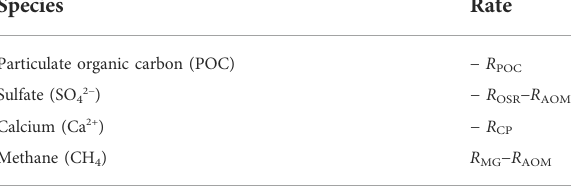
TABLE 3 Reaction terms of species considered in the model. Species Rate Particulate organic carbon